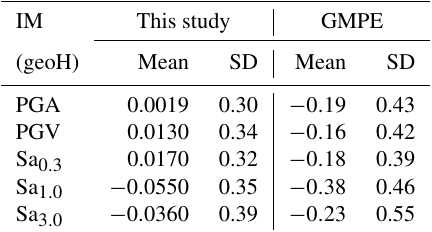
Table 4. Comparison of mean and standard deviation values of the residuals’ distributions obtained in this study and by means of GMPE (Bindi et al., 2014), regarding the earthquake that occurred on 30 October 2016 (241 data points for each IM; geoH stays for the geometric mean of the horizontal components). IM